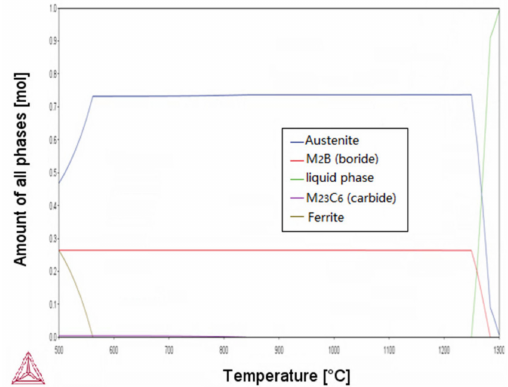
Figure 5. Calculated equilibrium phase content of BSS at 110 MPa and temperature from 500 to 1300 ◦ C.